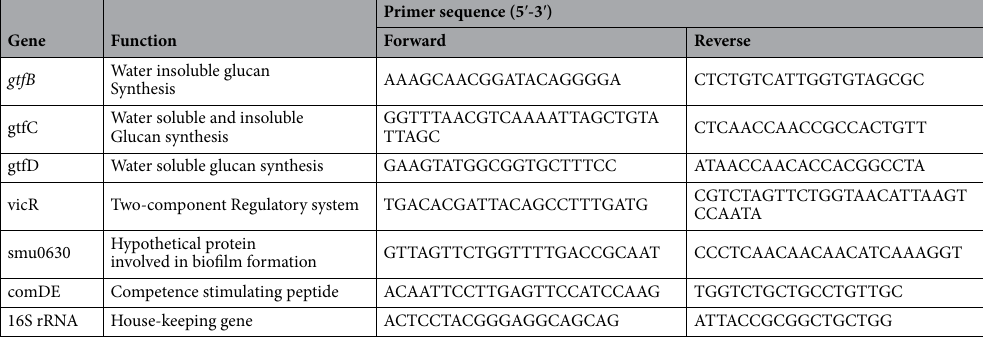
Table 2. List of genes, their influence in virulence attributes of S. mutans and respective primer sequences used in this